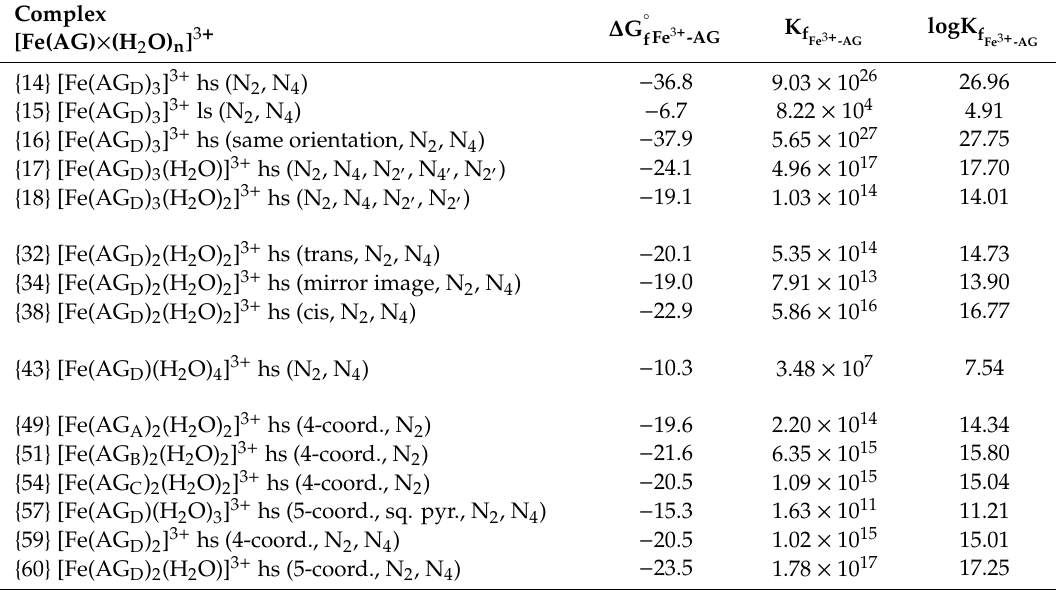
◦ Table 1. Standard Gibbs free energy change ( ∆ G , in kcal / mol) and formation constant (K f , logK f the most relevant complexes of Fe(III) with AG (as per Equation (7)) in aqueous solution at 298.15 K, ◦ taking into account the ∆ G to form AG from AGH + at physiological pH a